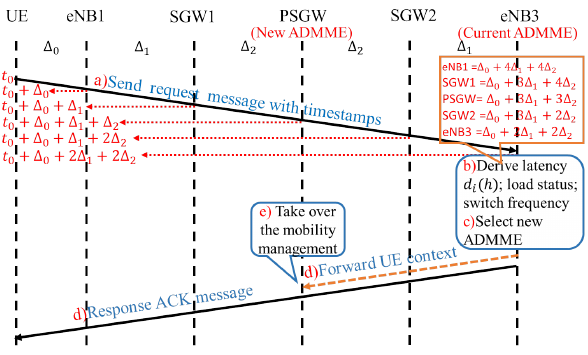
Figure 3: the h -th TAU/Handover